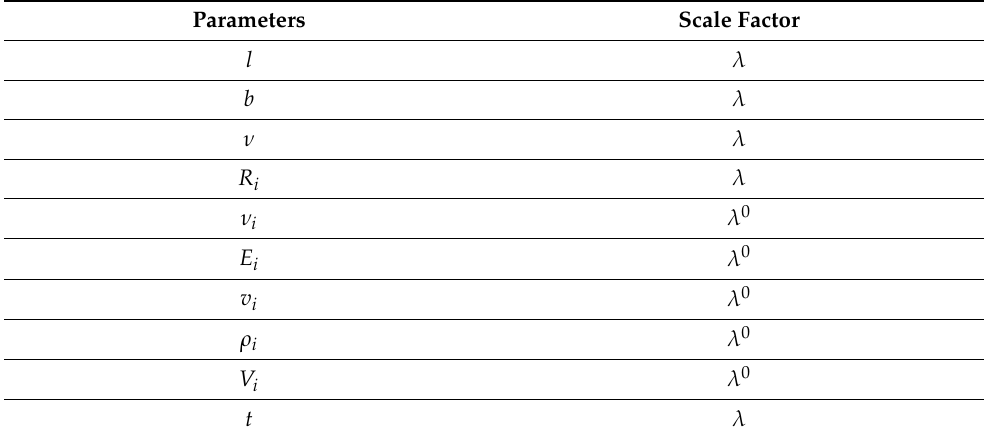
Table 2. System parameter scale factor table.